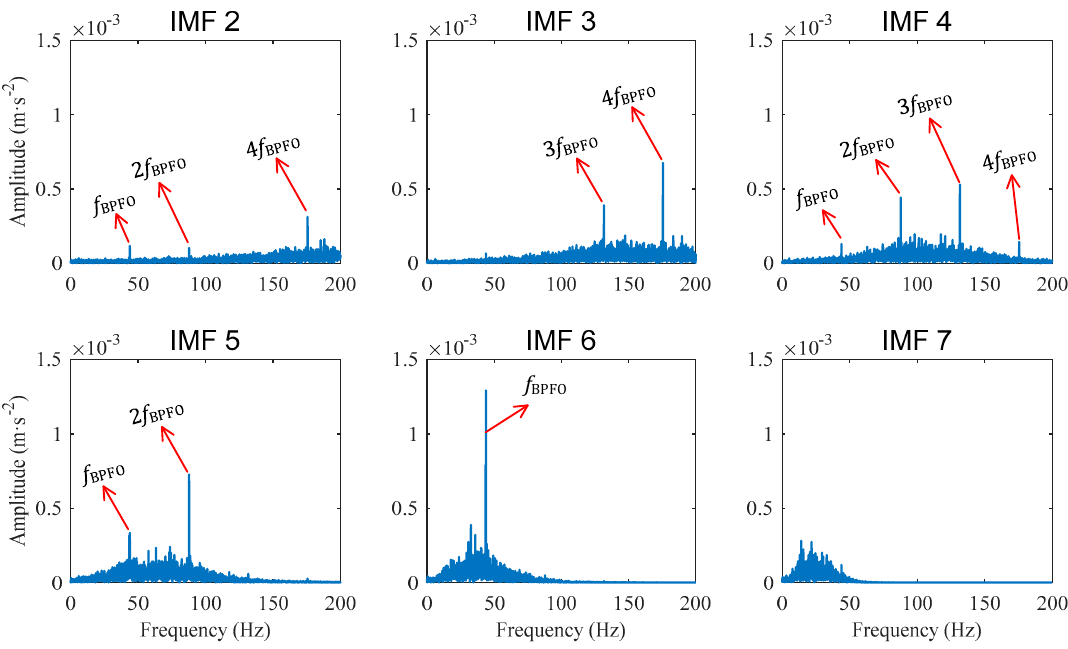
Figure 8. Case 1 for outer race defect: Amplitude spectra of IMFs obtained from compressed signal.